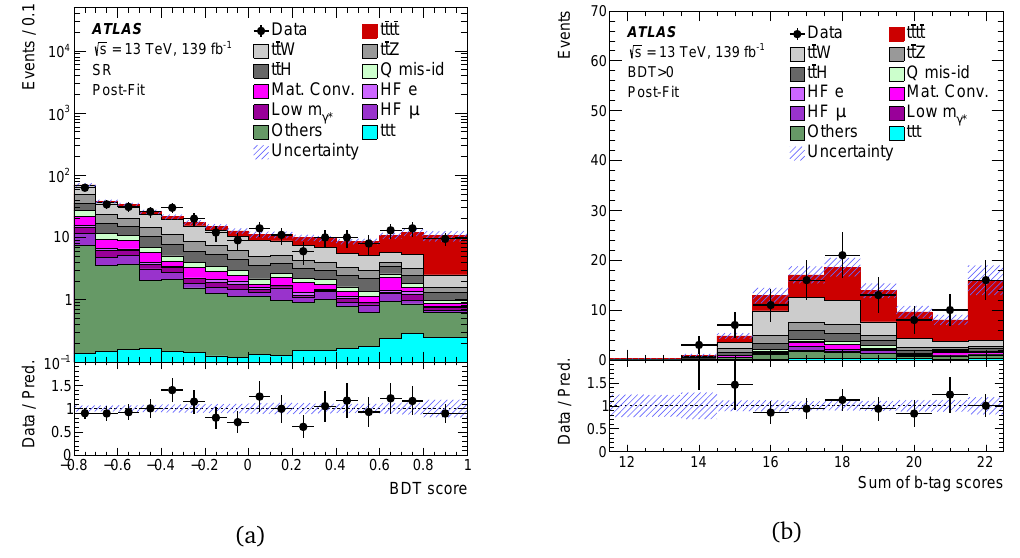
Figure 2: (a) The BDT distribution in the SR. (b) Sum of b-tag score in the high BDT region. Shaded bands represent both statistical and systematic uncertainties [ 8 ]